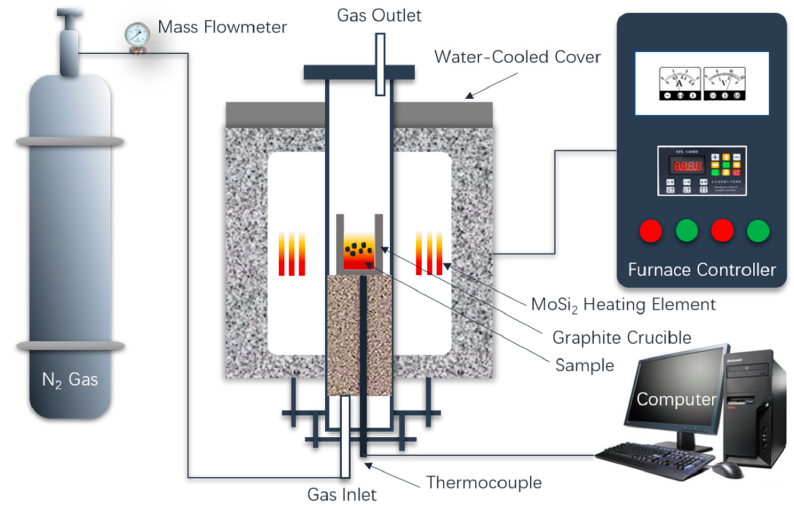
Figure 2. Experimental platform of OS absorption by pyrolysis of BFS. Table 4. Experimental plan for the pyrolysis of OS by BFS.